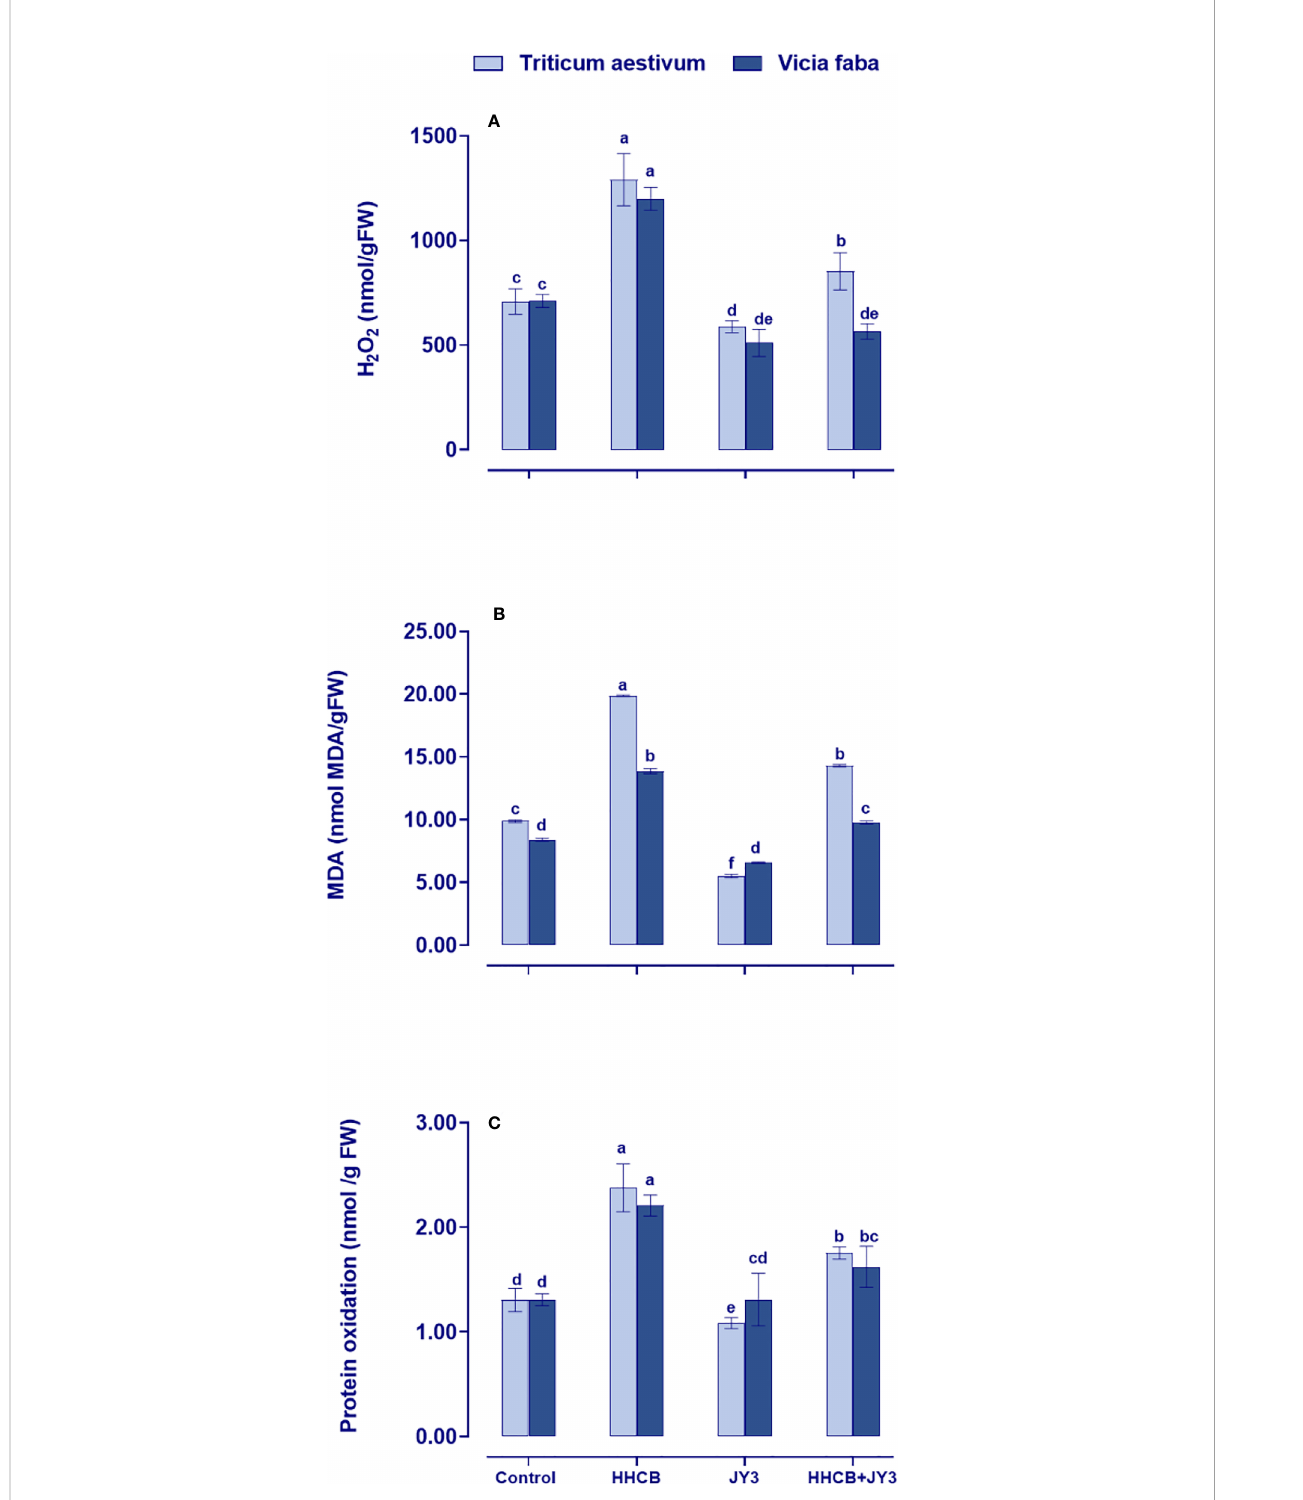
FIGURE 3 Effect of HHCB either alone or in combination with Rhodospirillum sp. JY3 on the oxidative markers; (A) Hydrogen peroxide (H2O2), (B) Monoaldehyde (MDA) and (C) Protein oxidation of both wheat and faba beans. Three biological replicates were used to detect each value. The bars on the columns represent error bars (SE). One-way ANOVA test was used to determine the signi fi cant difference between the groups. Similar letters on the bars indicate no signi fi cant difference between